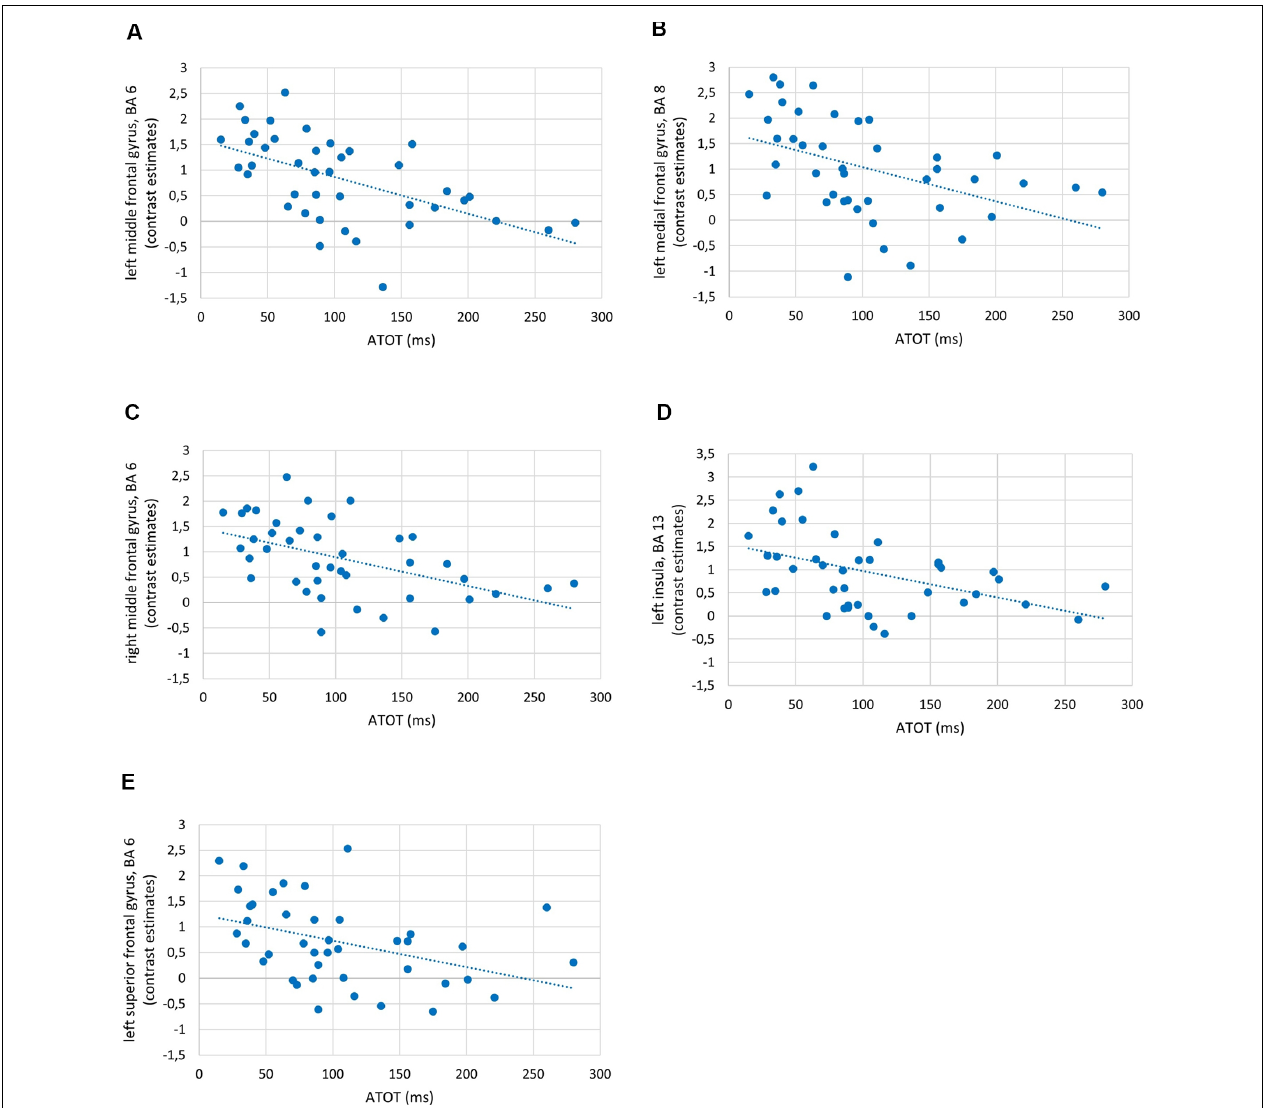
FIGURE 5 | Examples of correlations between temporal-order threshold (ATOT) values and brain activity in regions of interest (ROIs) with peak level activation in (A) left middle frontal gyrus (MFG), BA 6; (B) left medial frontal gyrus, BA 8; (C) right MFG, BA 6; (D) left insula, BA 13; and (E) left superior frontal gyrus (SFG), BA 6.